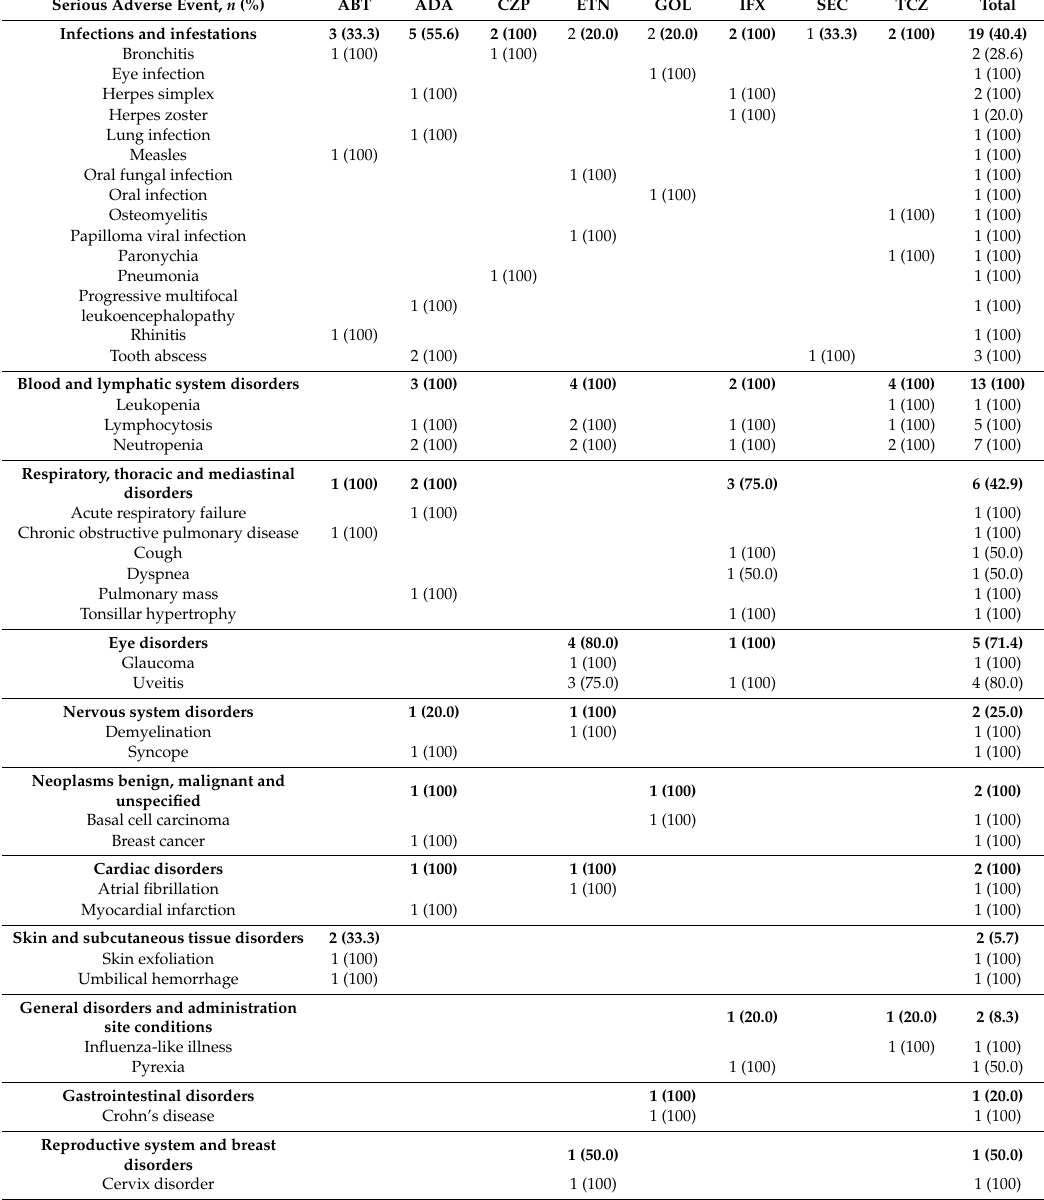
Table 5. Serious adverse event distribution by bDMARDs according to MedDRA ®